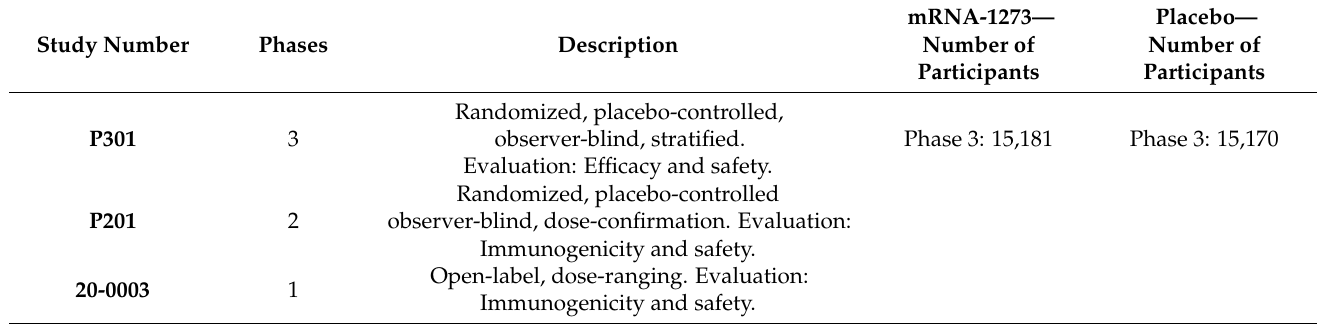
Table 4. Moderna’s COVID-19 Vaccine—Study Description